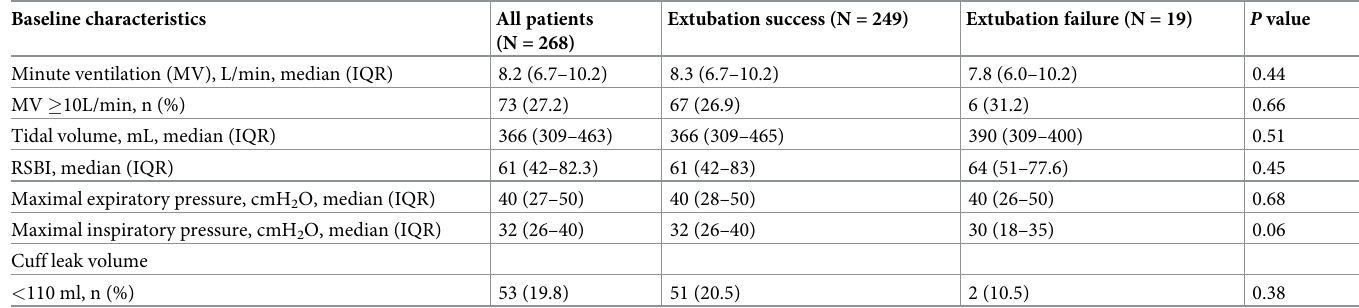
Table 2. Weaning parameters before planned extubation.